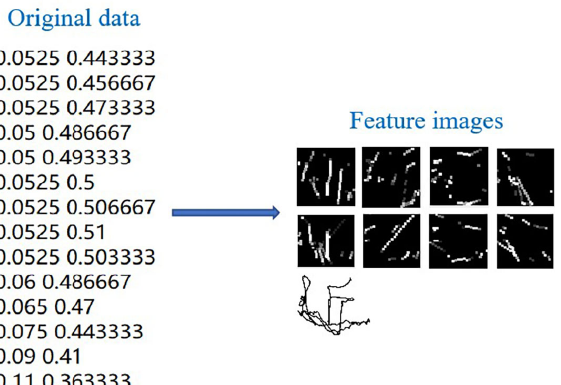
Figure 2. Examples of in-air handwritten Chinese